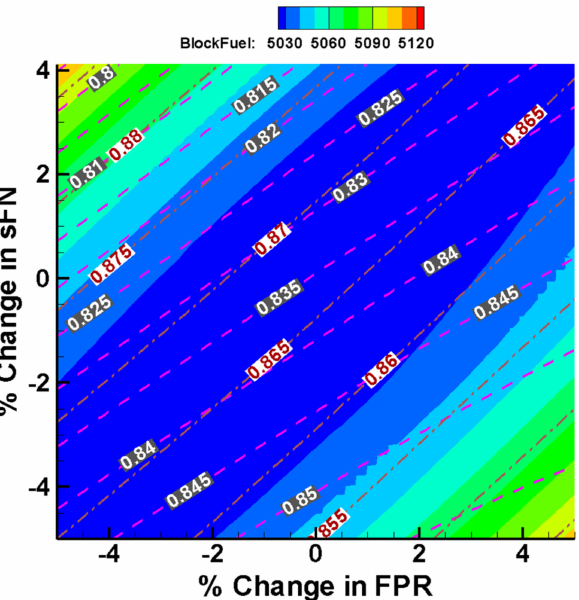
Figure 8. FB contour plot with FPR and sFN at ToC and isolines of transfer (dashed-dotted lines) and propulsive (dashed lines) efficiency at